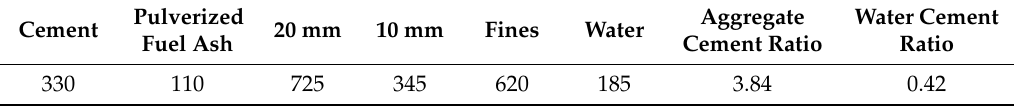
Table 4. Mix design of the cement (kg / m 3